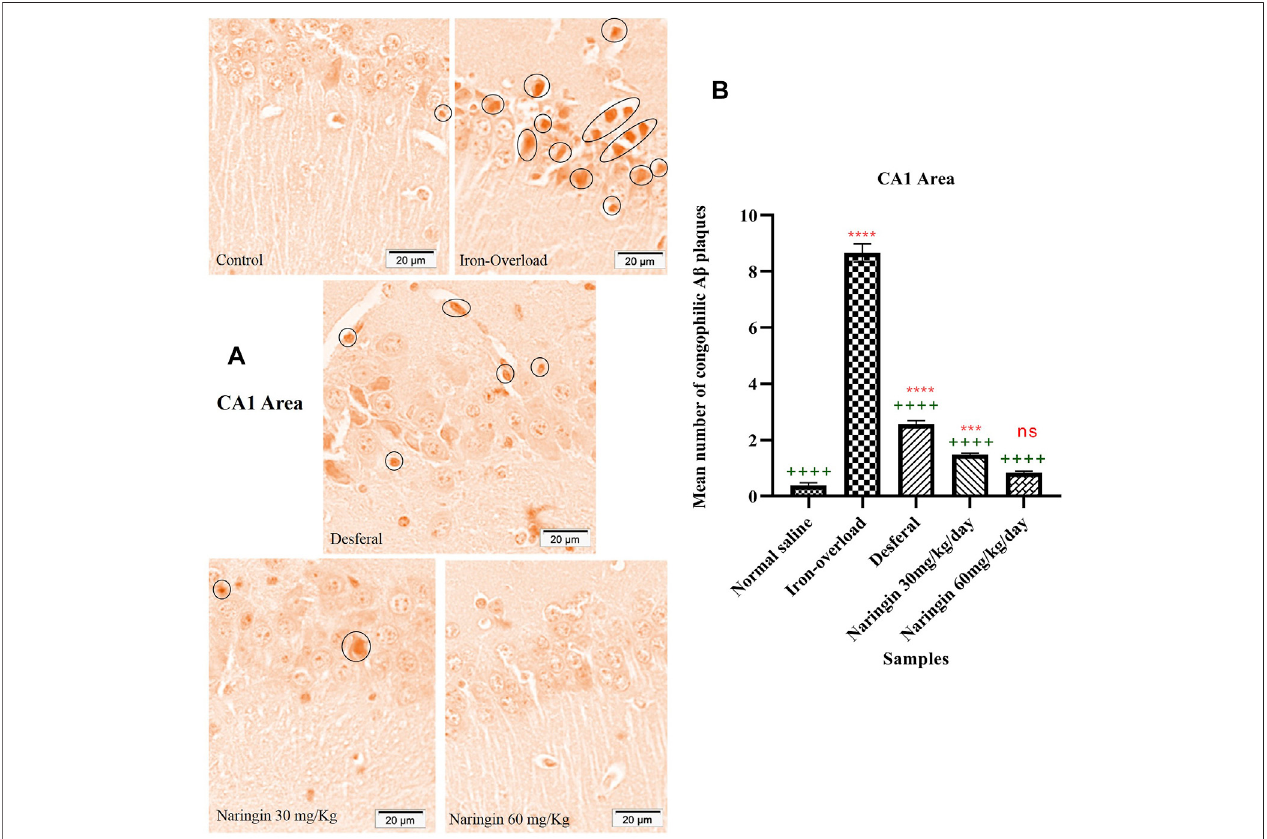
FIGURE 4 | (A) and (B) CR staining for amyloid- β plaque and the number of amyloid plaques in the hippocampal CA1 area of the mice hippocampus, (C) and (D) CR staining for amyloid- β plaque and the number of amyloid plaques in the hippocampal CA3 area of the mice hippocampus, and (E) and (F) CR staining for amyloid- β plaque and the number of amyloid plaques in the hippocampal DG area of the mice hippocampus. Control group: the mice that were treated by normal saline; iron- overload group: the mice that were treated by iron dextran; DFO group: iron-overloaded mice that were treated by DFO; naringin 30 mg/kg/day group: iron- overloadedmicethatweretreatedbynaringin30 mg/kg/day;naringin60 mg/kg/daygroup:iron-overloadedmicethatweretreatedbynaringin60 mg/kg/day.Scalebar shows 20 μ m.A β plaques are red incolor,and they areshown byablackcircle. “ ++++, ”“ +++, ” and “ ns ” indicateprobabilitylevelsof0.0001,0.001, and nonsigni fi cant, respectively. The stars indicate the probability levels in the same way. “ * ” shows the comparison of the mean of all groups with the control group. “ + ” shows the comparison of the mean of all groups with the iron-overloaded